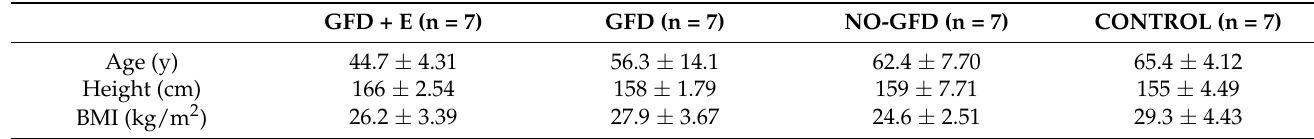
Table 2. Characteristic of celiac participants included in